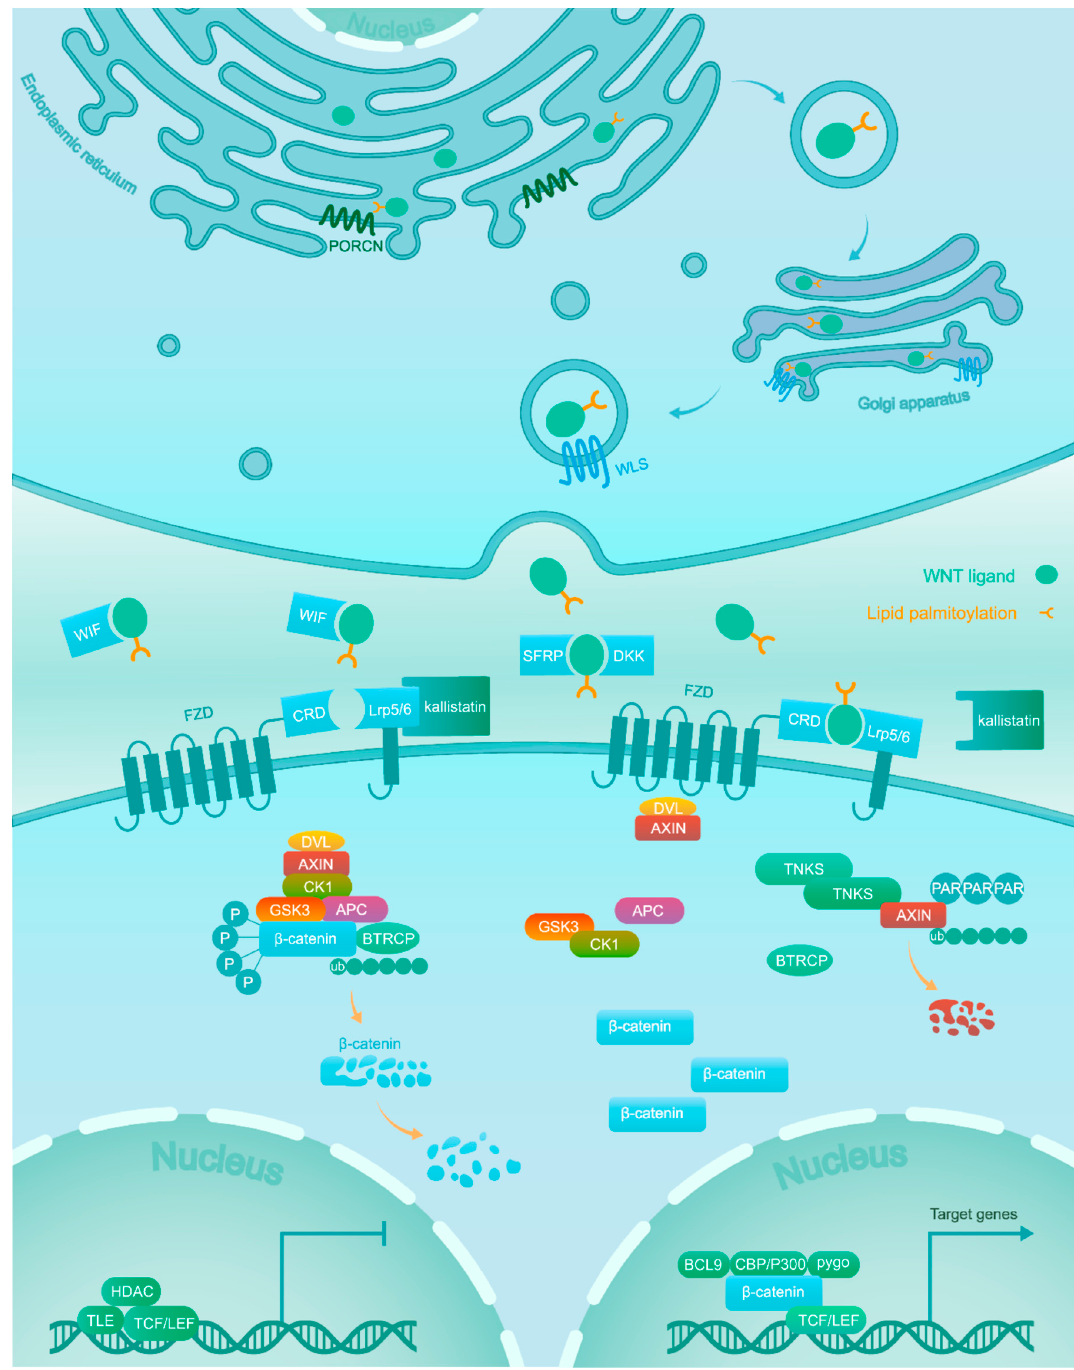
Figure 1. Wnts are lipid-modified by PORCN in the ER and escorted by WLS from the Golgi to the plasma membrane for secretion. In the absence of Wnt ligands due to Wnt antagonists (WIF, DKK, and SFRP) and Kallistatin, β -catenin is phosphorylated by a destruction complex consisting of GSK3, CK1, APC and AXIN. Phosphorylated β -catenin is targeted for proteasomal degradation after ubiquitination. In the nucleus, the TCF/LEF transcription factor activity is repressed by transducin-like enhancer of split (TLE) and histone deacetylase (HDAC). Association of Wnt ligands with their receptors leads to the dissociation of the destruction complex. As a result, β -catenin accumulates in the cytoplasm and translocates into the nucleus, where it promotes the expression of target genes via interaction with TCF/LEF and co-activators such as CBP/300, BCL9, and Pygo.